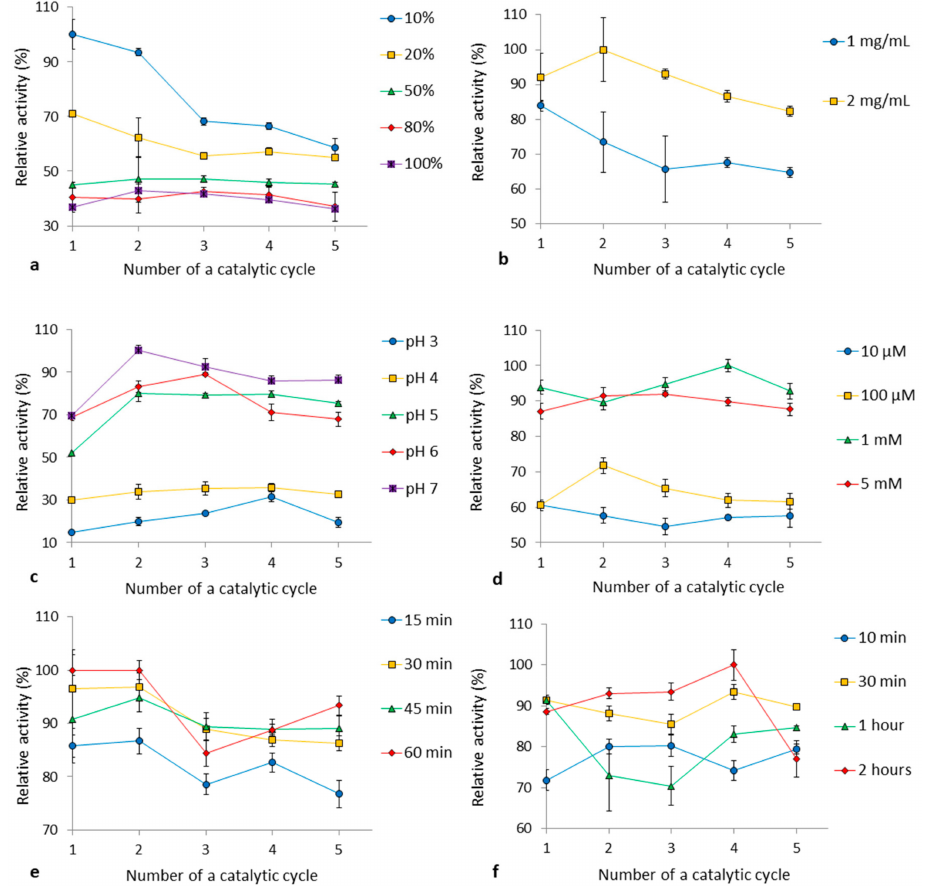
Figure 3. Parameters influencing laccase immobilization—concentration McIlvaine’s bu ff er solution ( a ) (30-min oxidation with 1mM NaIO 4 , 1-h immobilization using 1 mg / mL stock solution at pH 4), concentration of laccase solution; ( b ) (30-min oxidation with 1mM NaIO 4 , 1-h immobilization using 1 mg / mL stock solution at 20% pH 4 bu ff er), pH; ( c ) (30-min oxidation with 1mM NaIO 4 , 1-h immobilization using 2 mg / mL stock solution at 20% pH 4 bu ff er), concentration of sodium periodate; ( d ) (30-min oxidation, 1-h immobilization using 2 mg / mL stock solution at 20% pH 7 bu ff er), oxidation; ( e ) (oxidation with 1mM NaIO 4 , 1-h immobilization using 2 mg / mL stock solution at 20% pH 7 bu ff er), and immobilization time; and ( f ) (30-min oxidation with 1mM NaIO 4 , immobilization using 2 mg / mL stock solution at 20% pH 7 bu ff